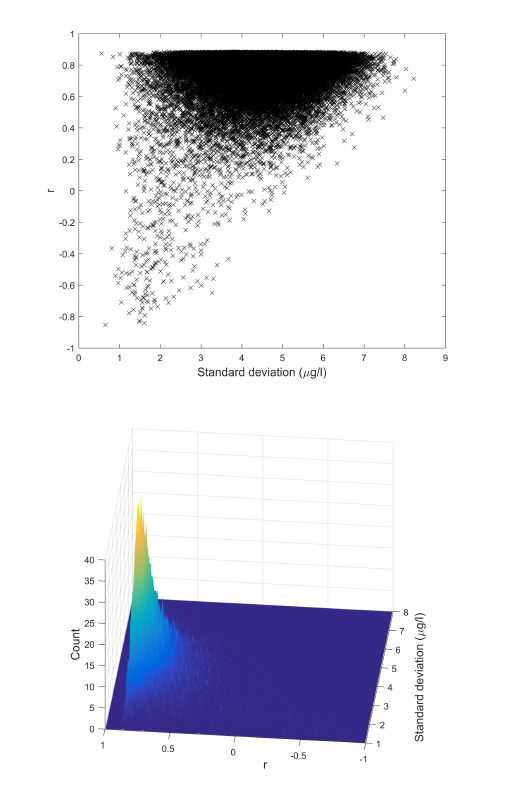
Figure 2. Correlation coefficient between Chl-a estimates of linear regression model and in-situ Chl-a measurements. Model is derived using 12 randomly selected reference Chl-a measurements (50000 random selections) and DN of five bands as variables. Result is presented as a function of standard deviation of Chl-a concentration of 12 reference samples. Top: scatter plot. Bottom: 2D histogram. Figure 4. Probability histogram (top) and cumulative probability histogram (bottom) derived from data presented in Figure 1. The standard deviation bins for which the sum of counts is below 30 are rejected from probability